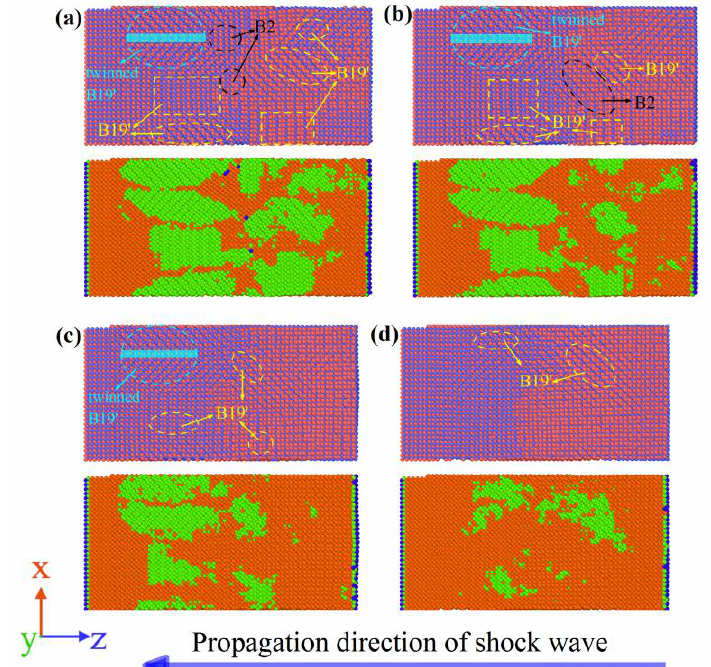
Figure 12. Reverse martensitic transformation and detwinning at Stage IV: ( a ) 10.2 ps; ( b ) 11.4 ps; ( c ) 12.8 ps; ( d ) 14.2 ps. (Orange and green represent the B2 phase and B19′ phase, respectively, but blue represents the other phase).